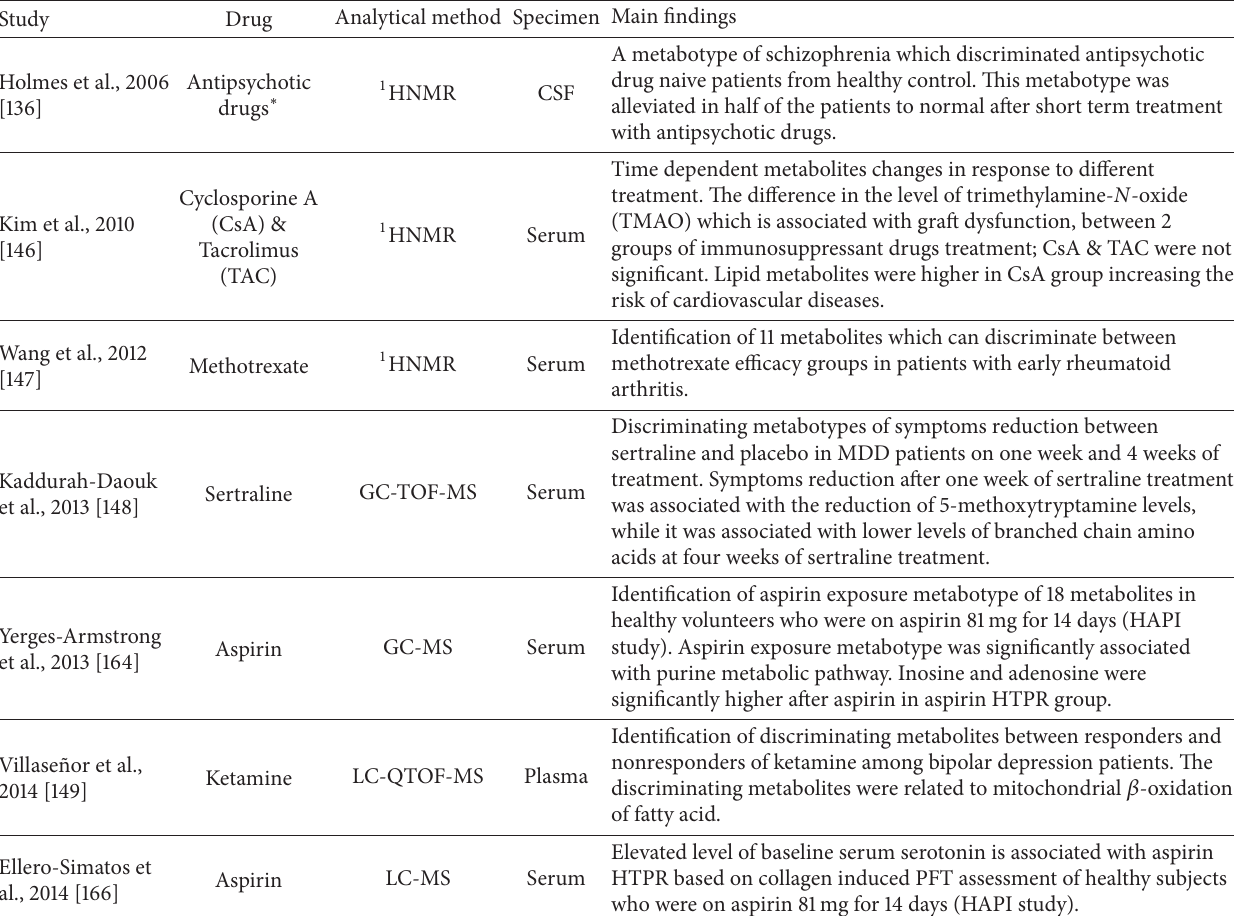
Table 3: Examples of pharmacometabolomics studies in humans.